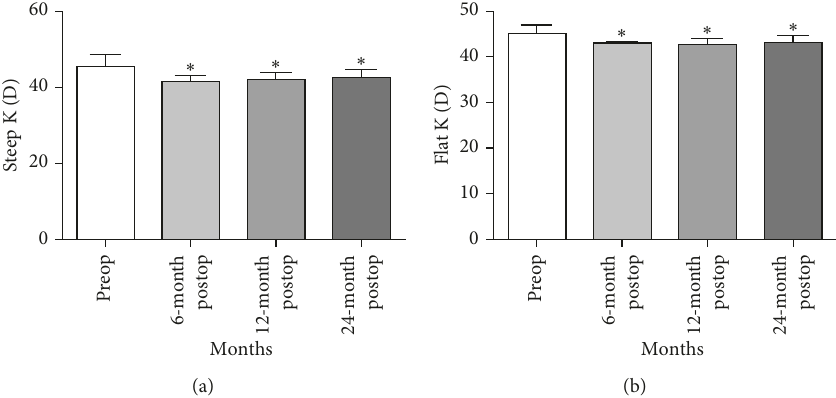
Figure 5: Preoperative and postoperative keratometry. (a) Phototherapeutic keratectomy combined with PRK and CXL significantly reduced the steep K values ( P < 0 . 05) at 6, 12, and 24 months follow-up. (b) Phototherapeutic keratectomy combined with PRK and CXL significantly reduced the flat K values at 6, 12, and 24 months follow-up. ∗ Preoperatively vs postoperatively 6, 12, and 24 months P < 0 .